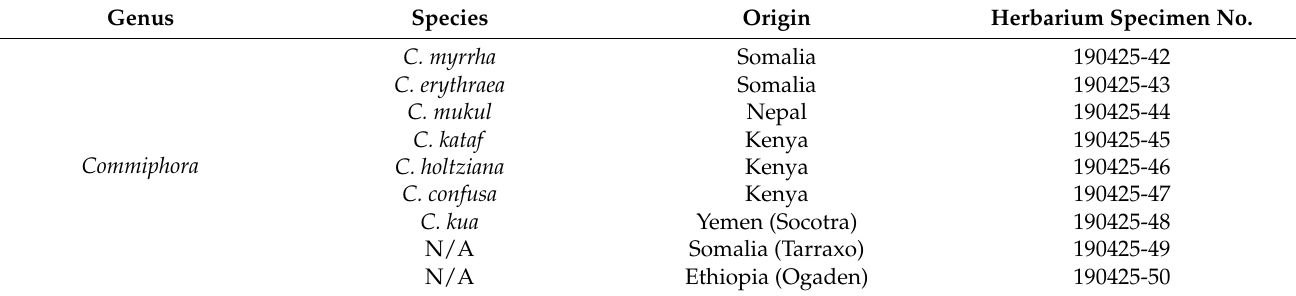
Table A1. Commiphora oleogum resin samples investigated. Specimens of all samples are deposited in the Herbarium of the Botanical Garden, Institute of Systemic Botany and Ecology, Ulm